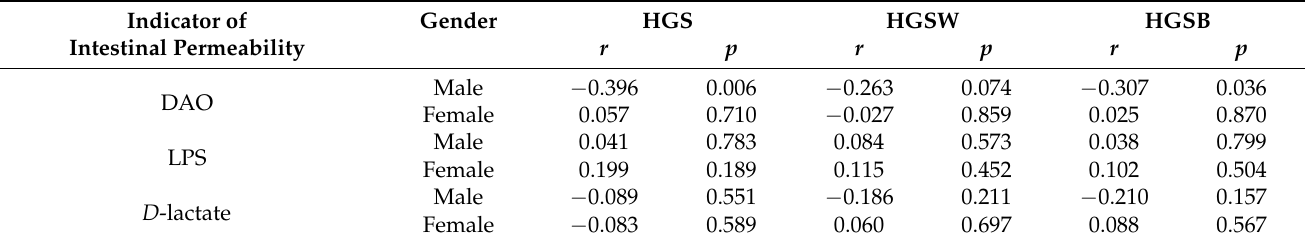
Table 2. Correlations among indicators of intestinal permeability and skeletal muscle strength.